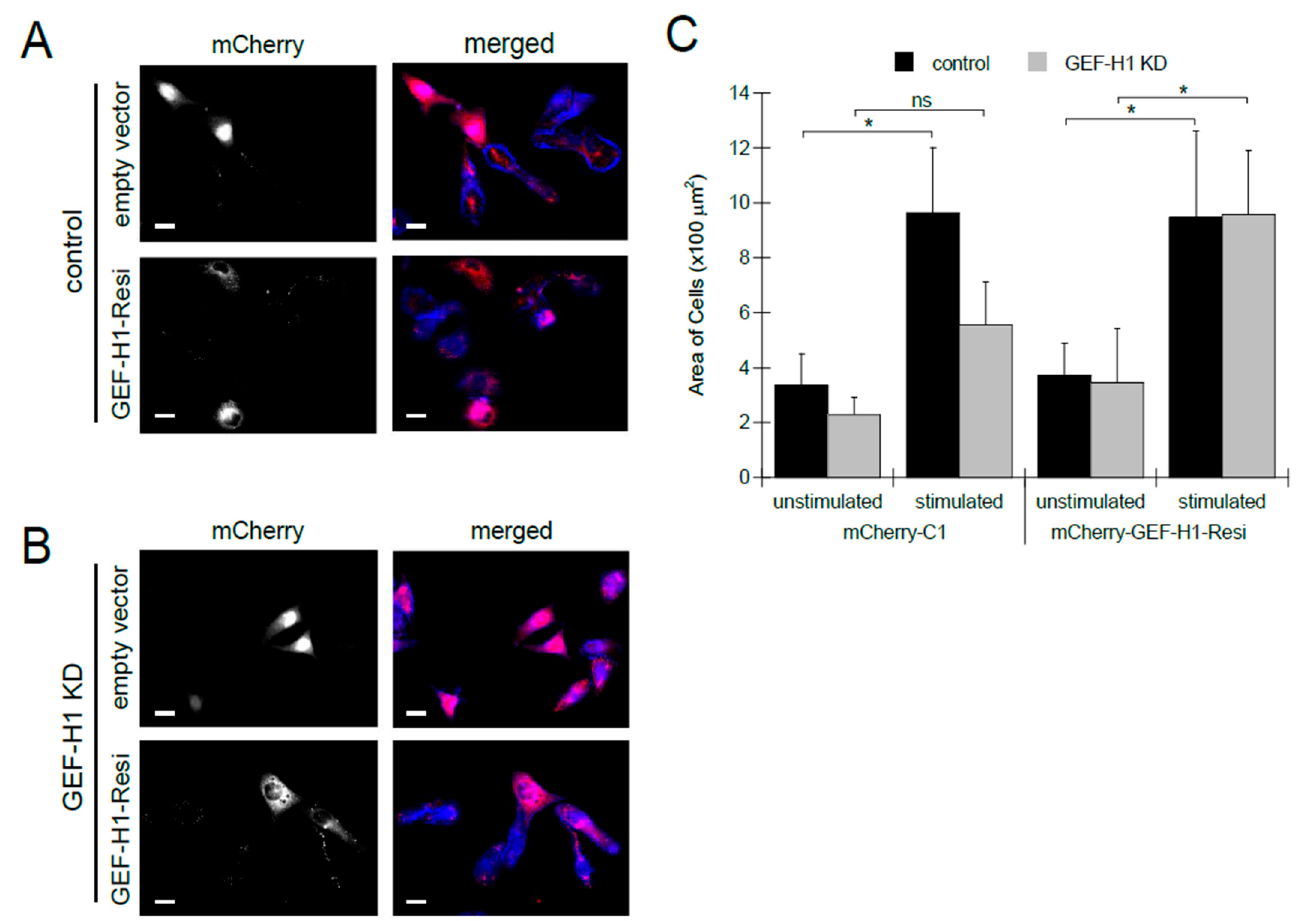
Figure 3. Expression of RNAi-resistant GEF-H1 restores cell spreading in antigen-stimulated GEF- H1-depleted RBL-2H3 cells. The GEF-H1 RNAi resistant construct (mCherry-GEF-H1-Resi) or empty vector (mCherry-C1) was transfected into the control ( A ) and GEF-H1-depleted (GEF-H1 KD) ( B ) cells. ( A , B ) Images of RBL-2H3 cells after 30 min of antigen stimulation. Granules are labeled with anti-CD63 antibody (red) and F-actin is labeled with Alexa Fluor 405-phalloidin (blue). Transfected cells (grayscale) are indicated by mCherry expression. Scale bar = 20 µm. ( C ) Quantifi- cation of cell size by ImageJ analysis. When stimulated, knockdown of GEF-H1 prevented cell spreading, while the expression of GEF-H1-Resi in GEF-H1-depleted cells restored cell spreading. For statistical analysis, the size of 5 to 8 cells per condition (replicate measurements) was averaged from three independent experiments. Differences in cell size between samples were analyzed by Kruskal–Wallis tests ( p = 0.00578). Dunn’s post hoc tests were used to identify significant differences between the size of unstimulated and stimulated cells (* p = 0.0282 for control and not significant (ns) for GEF-H1 KD cells transfected with mCherry-C1; * p = 0.0377 for control and * p = 0.0433 for GEF-H1 KD cells transfected with mCherry-GEF-H1-Resi).